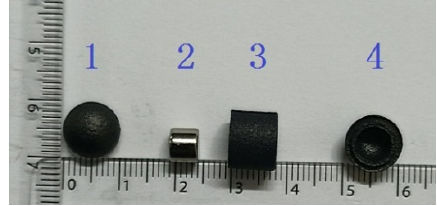
Figure 8. Parts of the capsule robot. 1—Front end cap; 2—Magnet; 3—Middle section; 4—Rear end cap.